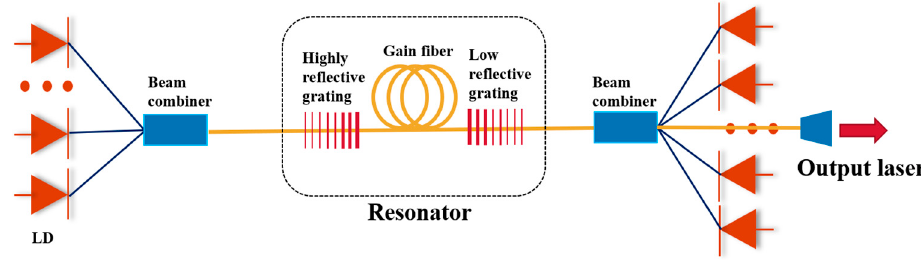
Figure 2. The schematics of one type of high-power fiber laser.